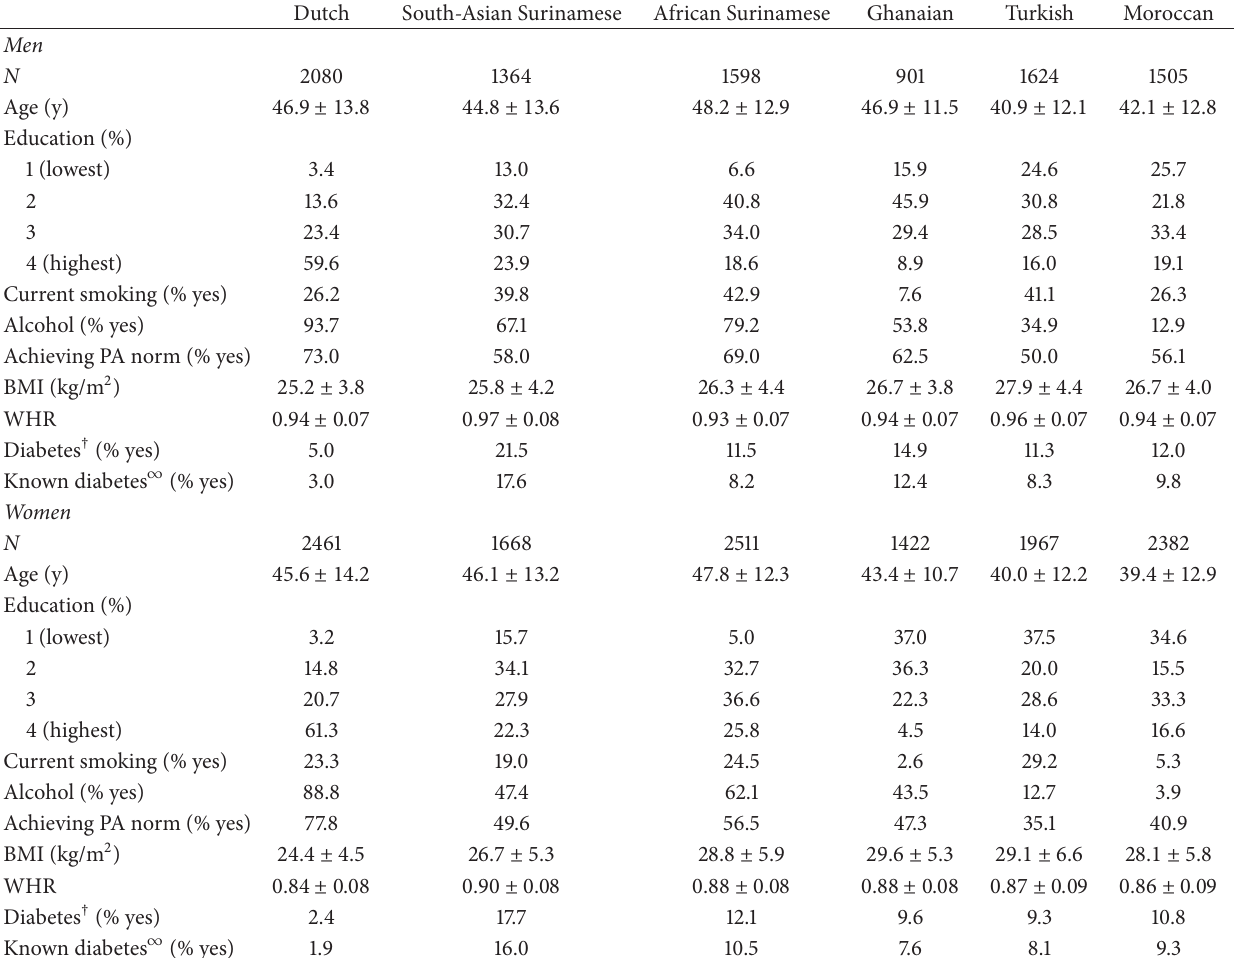
Table 1: Characteristics of the study population, by ethnicity and sex. Dutch South-Asian Surinamese African Surinamese Ghanaian Turkish Moroccan